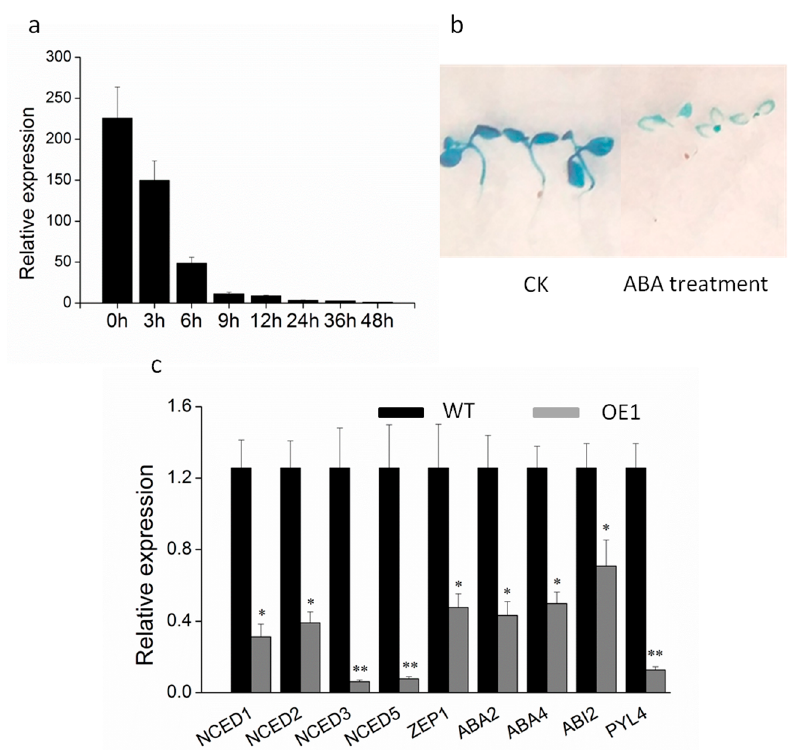
Figure 6. The expression of abscisic acid metabolism-related genes in WT and DRL1 -overexpressing transgenic plants. ( a ) The expression of DRL1 in grapevine following ABA treatment. ( b ) GUS staining in leaves of P DRL1 -GUS transgenic tobacco plants under ABA treatment. Six-day-old tobacco seedlings were treated ( n = 60). ( c ) Expression analysis of ABA biosynthesis- and regulation-related genes in wild-type and DRL1 -overexpressing transgenic tobacco plants. Asterisks represent statistically significant differences between wild-type and transgenic plants: * p < 0.05 and ** p < 0.01.